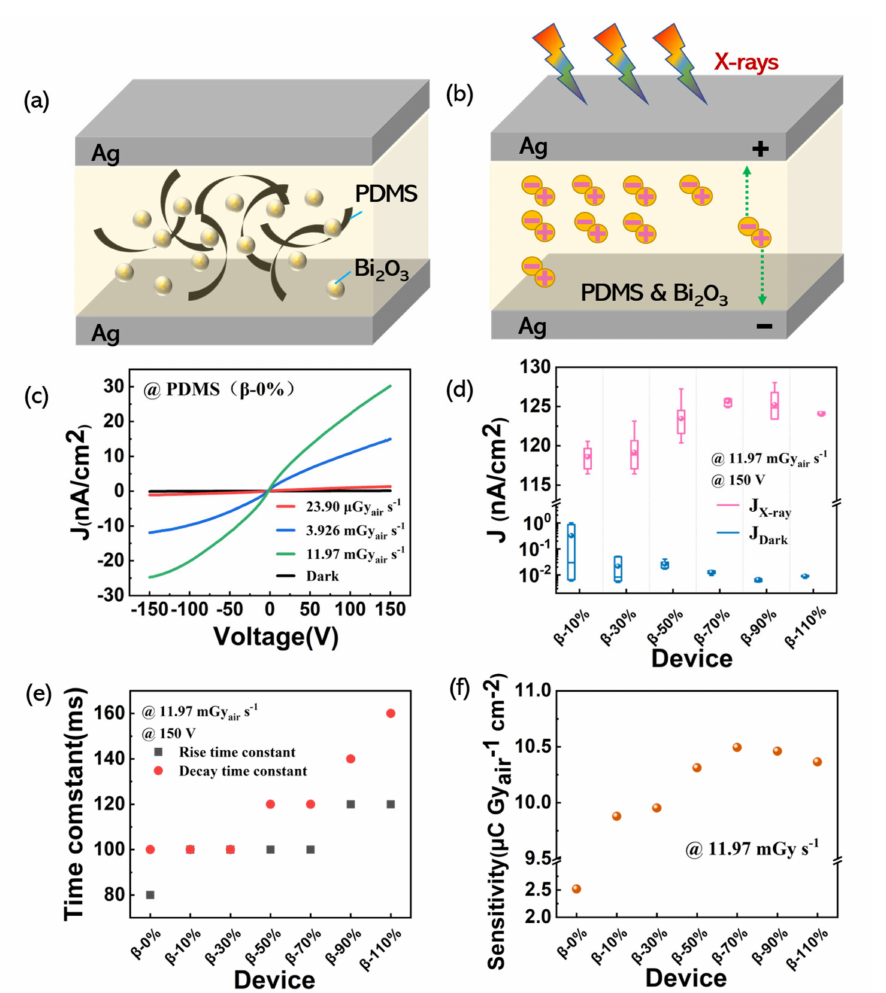
Figure 4. ( a ) The schematic of the device structure; ( b ) a diagram of the process of the conductivity induced by X-ray exposure of the detector; ( c ) the I-V curve of PDMS under different dose rates; ( d ) the X-ray and dark current density box plot of different devices and the error bars represent the range of the current density values; ( e ) rise and decay time constants for detectors with increasing β -Bi 2 O 3 nanoparticle loadings; ( f ) the sensitivity values for seven devices at 150 V bias